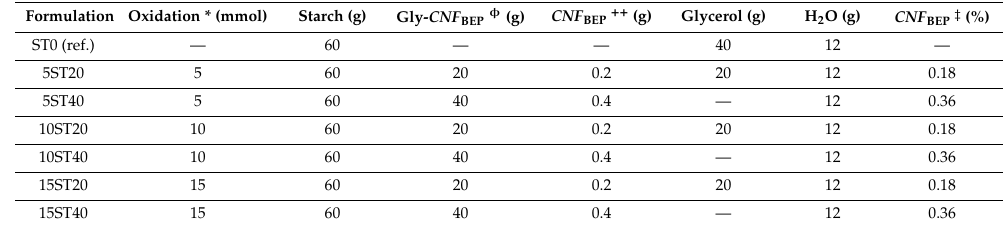
Table 1. Composition and nomenclature of thermoplastic starch films reinforced with CNF BEP fibers. * NaClO added to oxidize bleached eucalyptus pulp (BEP); φ : CNF BEP dispersed in glycerol (concentration of 1.0% w / w ); ++ CNF BEP included in the formulation; ‡ % of CNF BEP in the composite film considering the feed composition of the whole composite. Formulation Oxidation * (mmol) Starch (g) Gly- CNF BEP φ (g) CNF BEP ++ (g) Glycerol (g) H 2 O